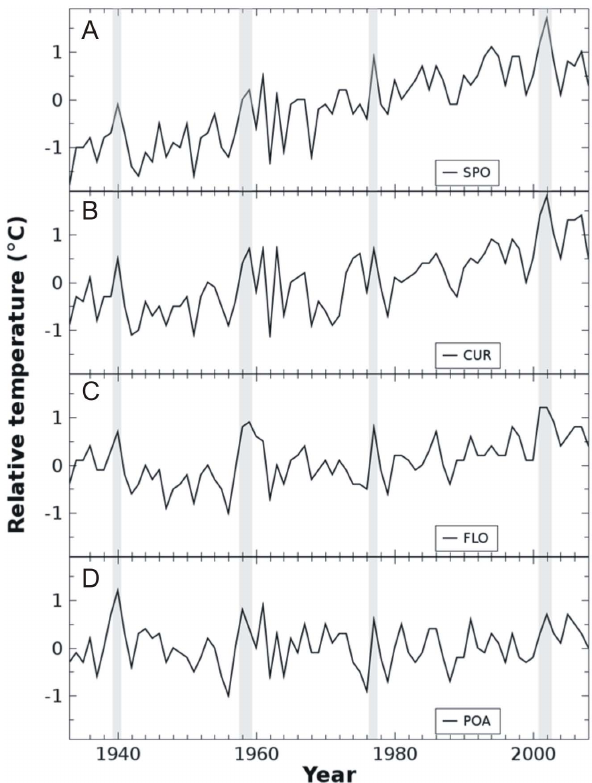
Fig. 3. Time series of the relative temperature between 1933 and 2008 for four Brazilian meteorological stations: SPO (A) , CUR (B) , FLO (C) and POA (D) . The shaded bands indicate simultaneous maximum temperature